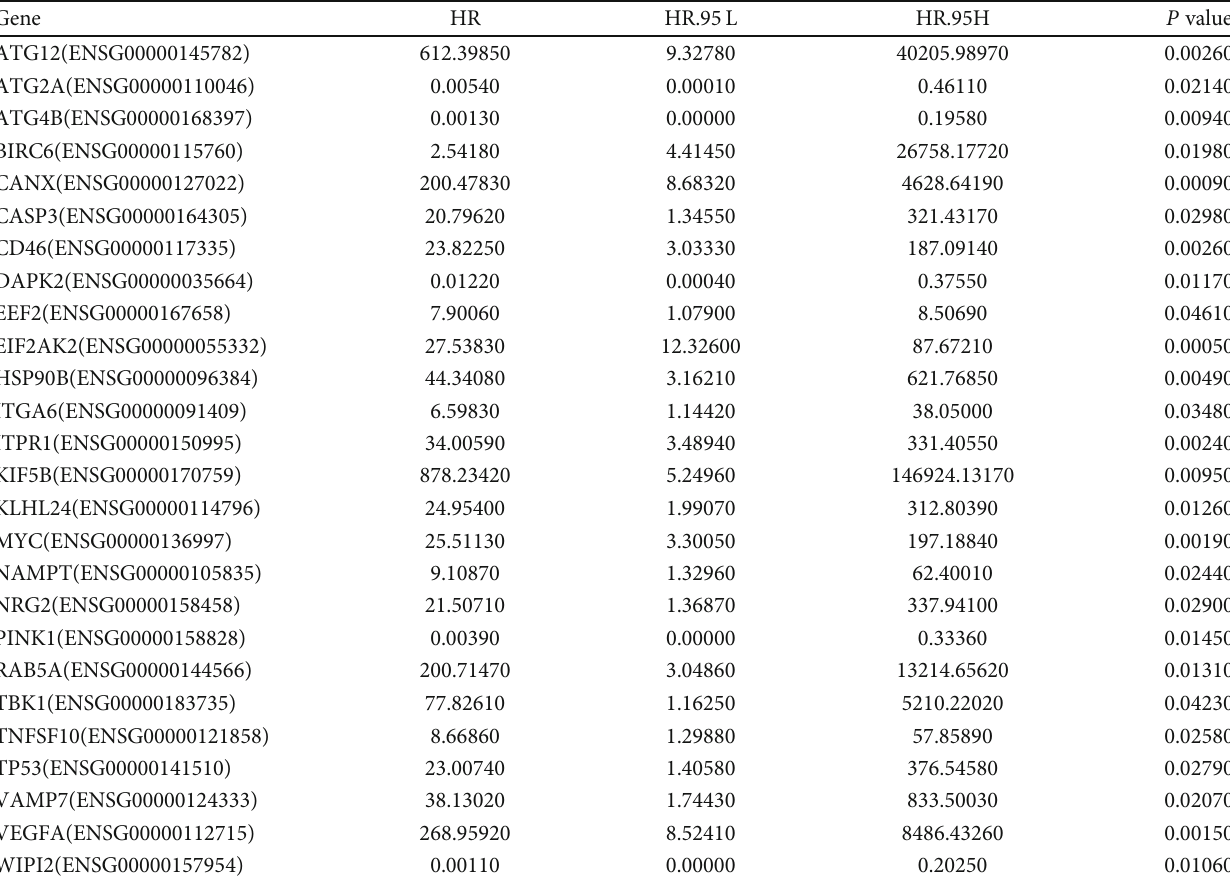
Table 1: Overall survival-related ARGs in the MM patients ( P < 0 : 05